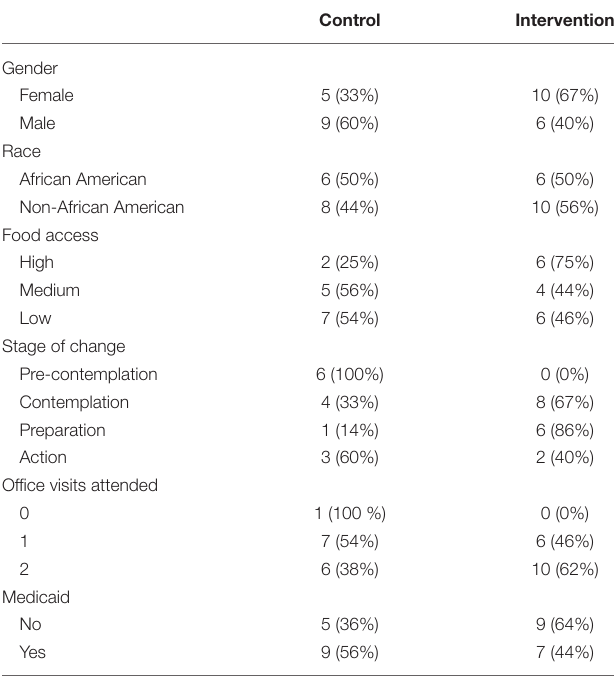
TABLE 1 | Baseline demographic characteristics of control and intervention participants. Control